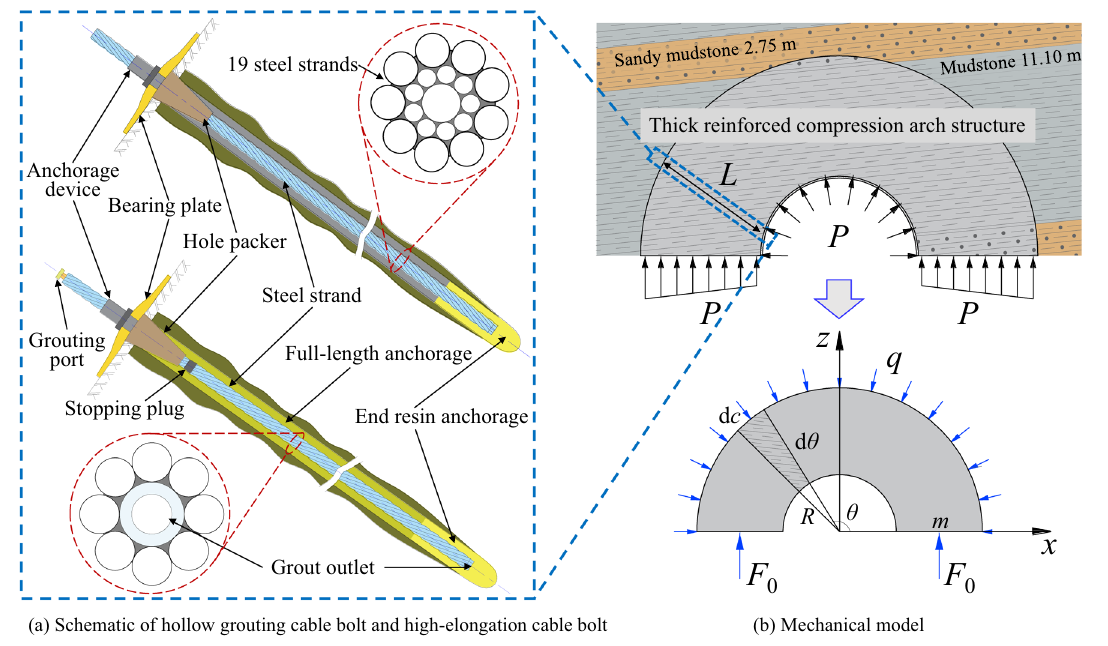
(a) Schematic of hollow grouting cable bolt and high-elongation cable bolt (b) Mechanical model Fig. 17 Construction of thick reinforced compression arch